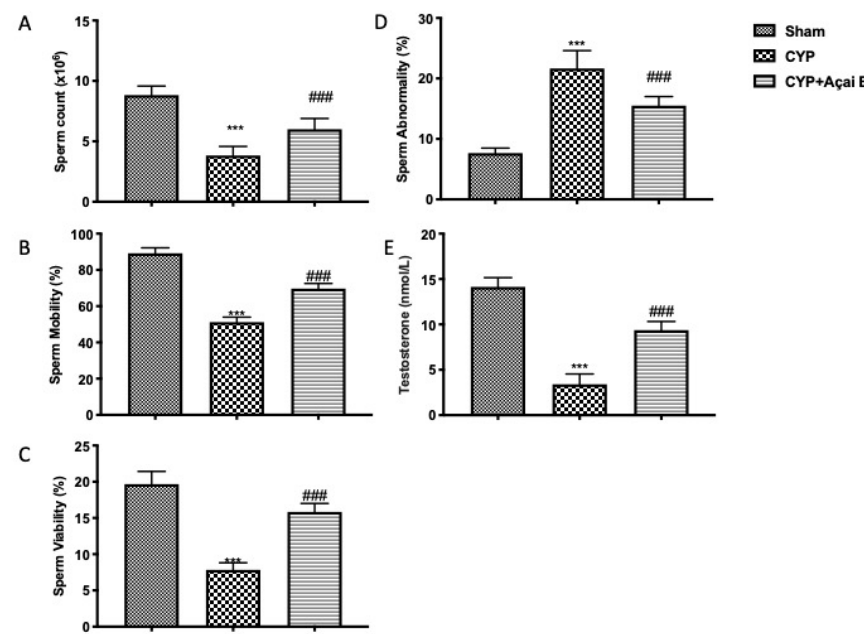
Figure 5. Effect of açai berry administration on sperm parameters and testosterone levels after CYP administration: ( A ) sperm count, ( B ) sperm motility, ( C ) sperm viability, ( D ) sperm abnormality, ( E ) serum testosterone level. *** p < 0.001 vs. sham; ### p < 0.001 vs. CYP.